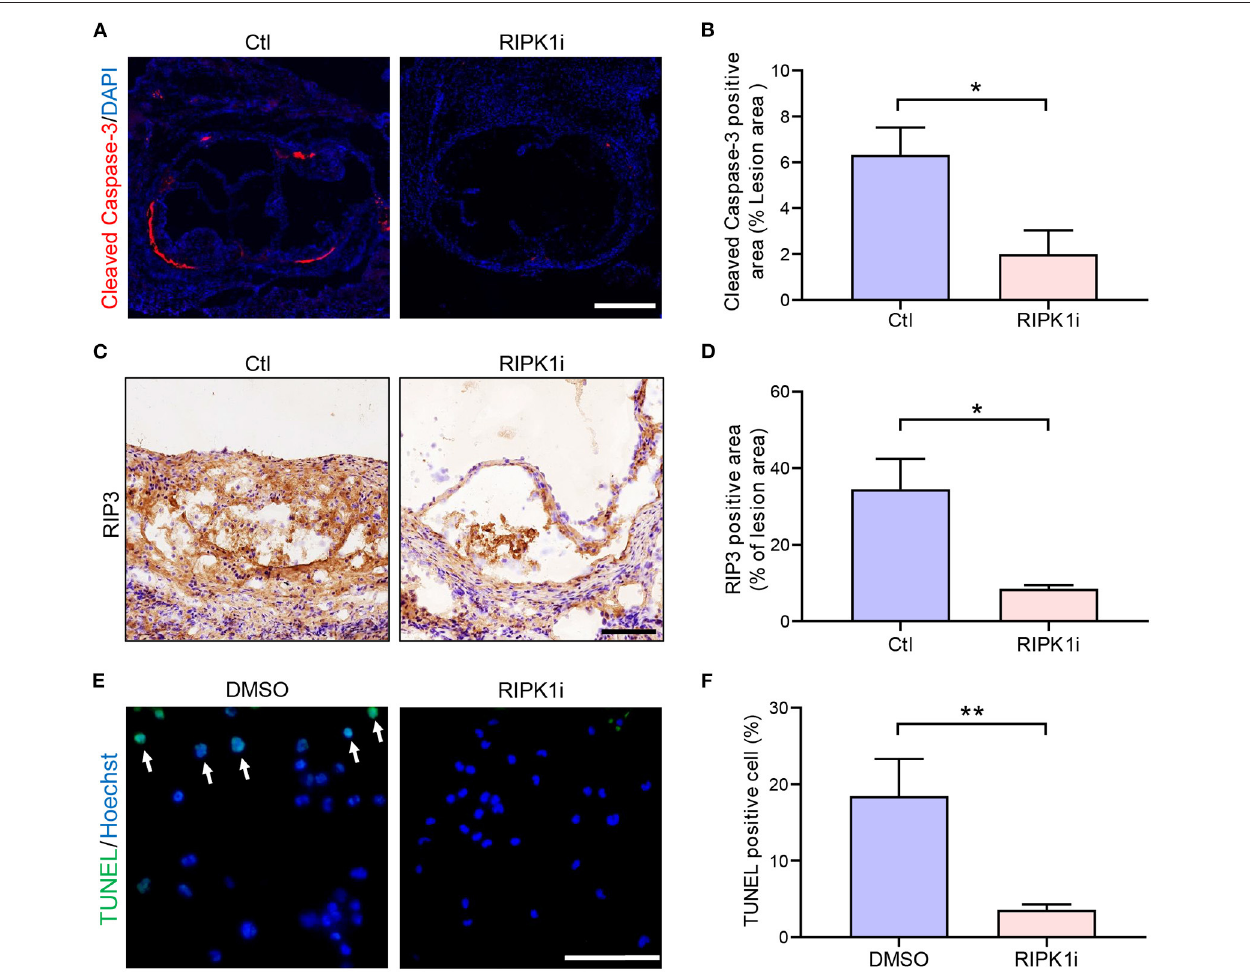
FIGURE 5 | RIPK1i suppressed cell apoptosis and necroptosis in plaque. (A–D) Histological analysis of cross-sections from aortic sinus of ApoE SA / SA mice. (A) Representative immunofluorescence images of Cleaved Caspase-3 staining (red) in aortic sinus. Scale bar = 500 µ m. (B) Quantification of apoptosis (Cleaved Caspase-3 positive) area ( n = 5). (C) Representative IHC images of RIP3 in aortic sinus plaque. Scale bar = 100 µ m. (D) Quantification of necroptosis (RIP3 positive) area ( n = 6). (E) and (F) Peritoneal macrophages isolated from male ApoE SA / SA mice were pretreated with RIPK1i (50ng/ml) or DMSO for 3h, then stimulated with oxidized LDL (50 µ g/ml) for 24h and stained for TUNEL. (E) Representative immunofluorescence images of TUNEL staining (green). TUNEL positive cells are indicated by the white arrows. Scale bar = 50 µ m. (F) Percentage of TUNEL positive cell in peritoneal macrophages ( n = 6). All of the data represented as mean ± SEM; * P < 0.05, ** P < 0.01. Statistical analysis: unpaired student’s t -test (B) , non-parametric Mann-Whitney U test (D,F)